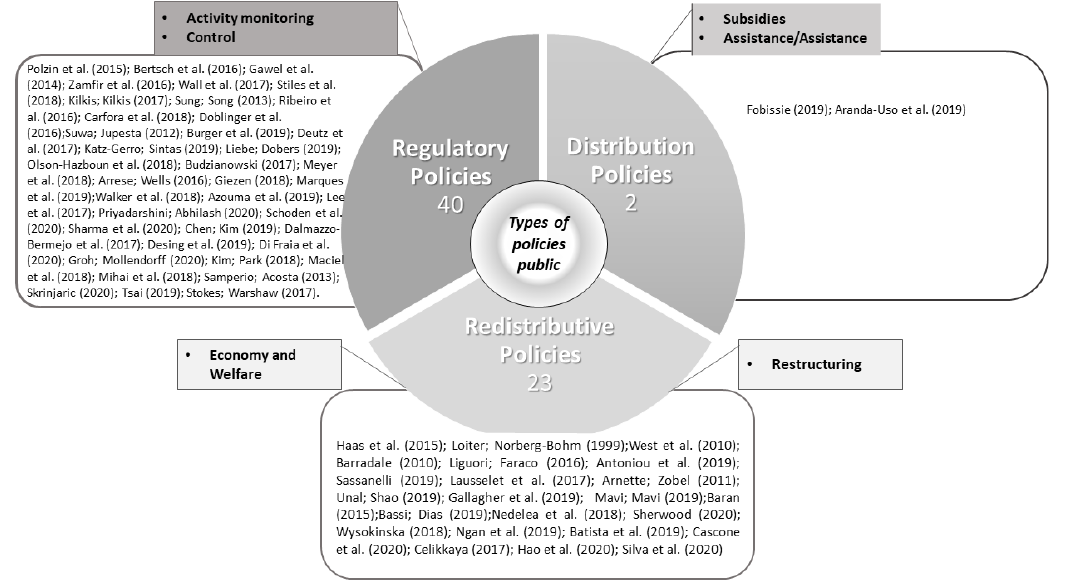
Figure 9. Telegraphic systematization of the research objective with the types of public policies ([6,7,9,12,13,15,16,18 – 20,38 – 47,49,51 – 63,65 – 93]).